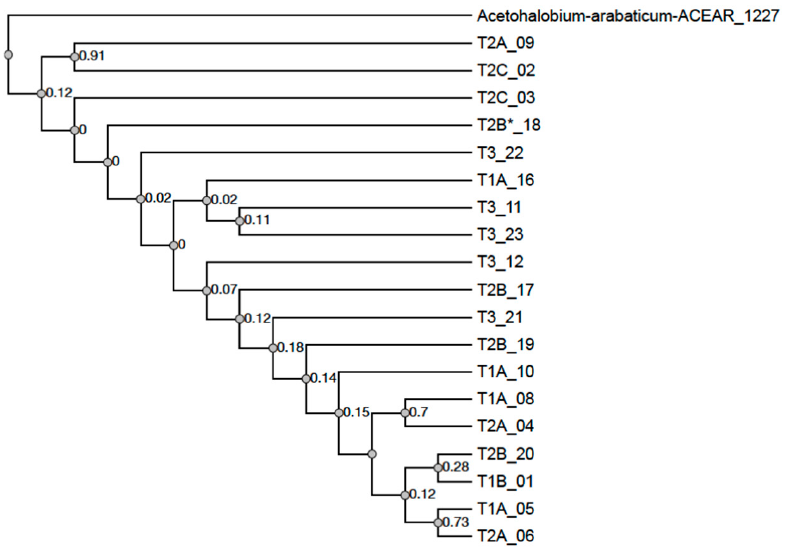
Figure 2. Cladogram of IS605 tnpB open reading frames. The cladogram is rooted to a similar sequence found in Acetohalobium arabaticum . Elements are labeled with their tnpB and locus position (example T2A_09 is a type 2A tnpB from locus 9). Analysis was performed with default parameters from NGphylogeny.fr using MAFFT (version 7.407_1) sequence alignment, BMGE (version 1.12_1) alignment curation, FastTree (version 2.1.10_1) tree inference, and Booster (version 0.2.4) branch support with a bootstrap of 100. Branch support values are low and sequences with known relationships (tnpB ORF inserts) do not clade.